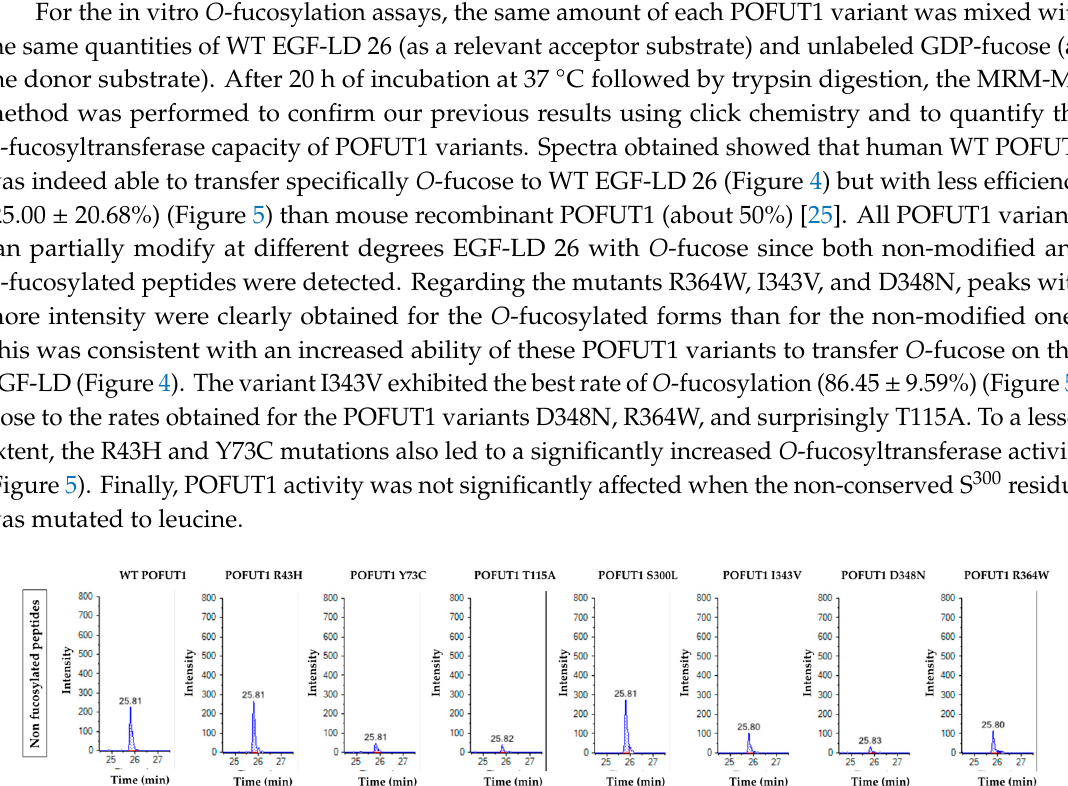
Figure 5. Quantification of the O -fucosyltransferase activity of WT POFUT1 and its seven mutated counterparts found in CRC patients. The percentage of O -fucosylation was determined from previous MRM-MS analyses based on ratios of peak areas of O -fucosylated peptides reported to those of total peptides. Bar graph represented mean of percentage ± SD. Each experiment was performed three times independently. Statistical significance was assessed using a two-tailed Student test; * p < 0.05, ** p < 0.01 vs. WT. 3. Discussion POFUT1 was recently shown to exert an essential role in the colorectal progression from precancerous lesions (adenomas) to carcinoma [32]. The overexpression of this O -fucosyltransferase,